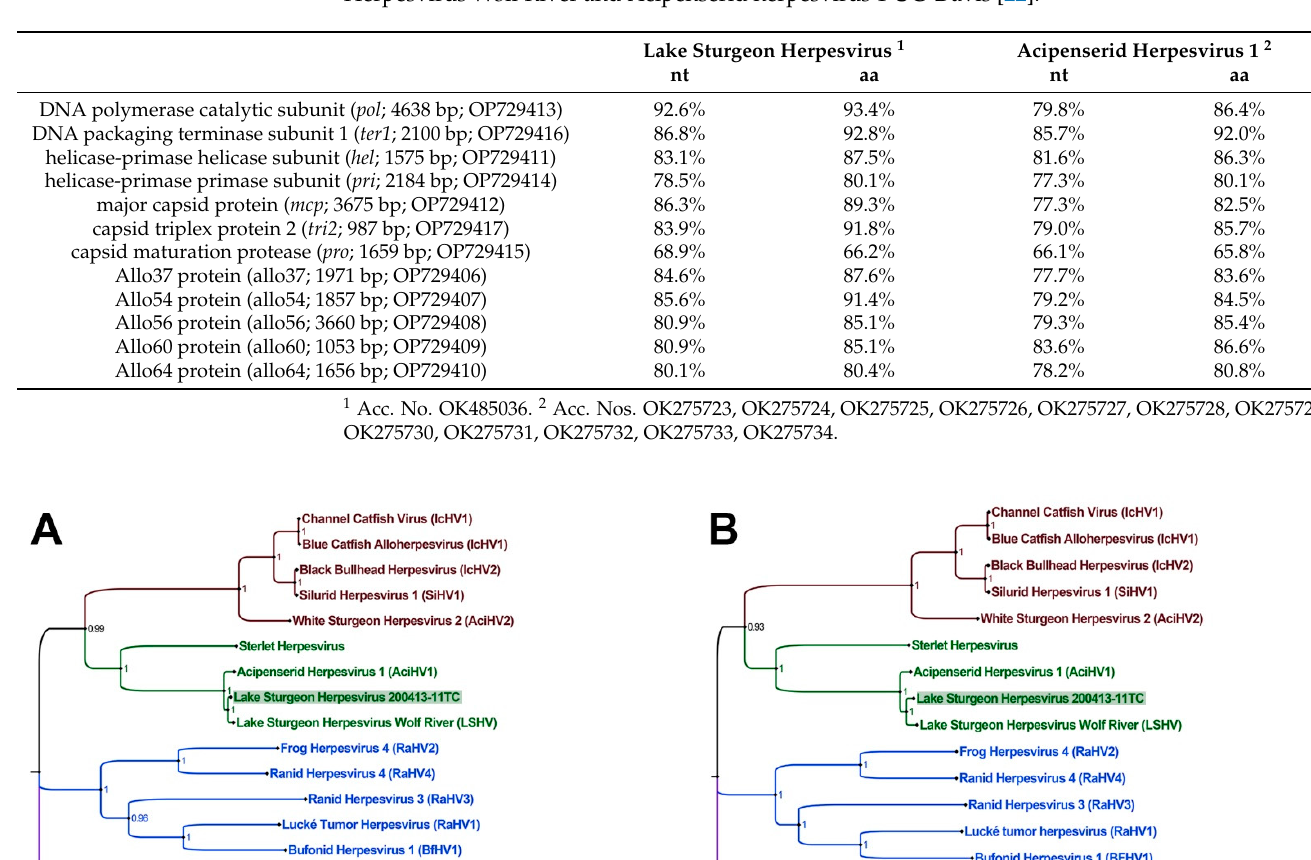
Table 4. Pairwise comparisons from MAFFT alignments of 12 core alloherpesvirus ORFs from lake sturgeon herpesvirus isolate 200413-11TC (Acc. Nos. OP729406-OP729417) to Lake Sturgeon Herpesvirus Wolf River and Acipenserid herpesvirus 1 UC-Davis [22].